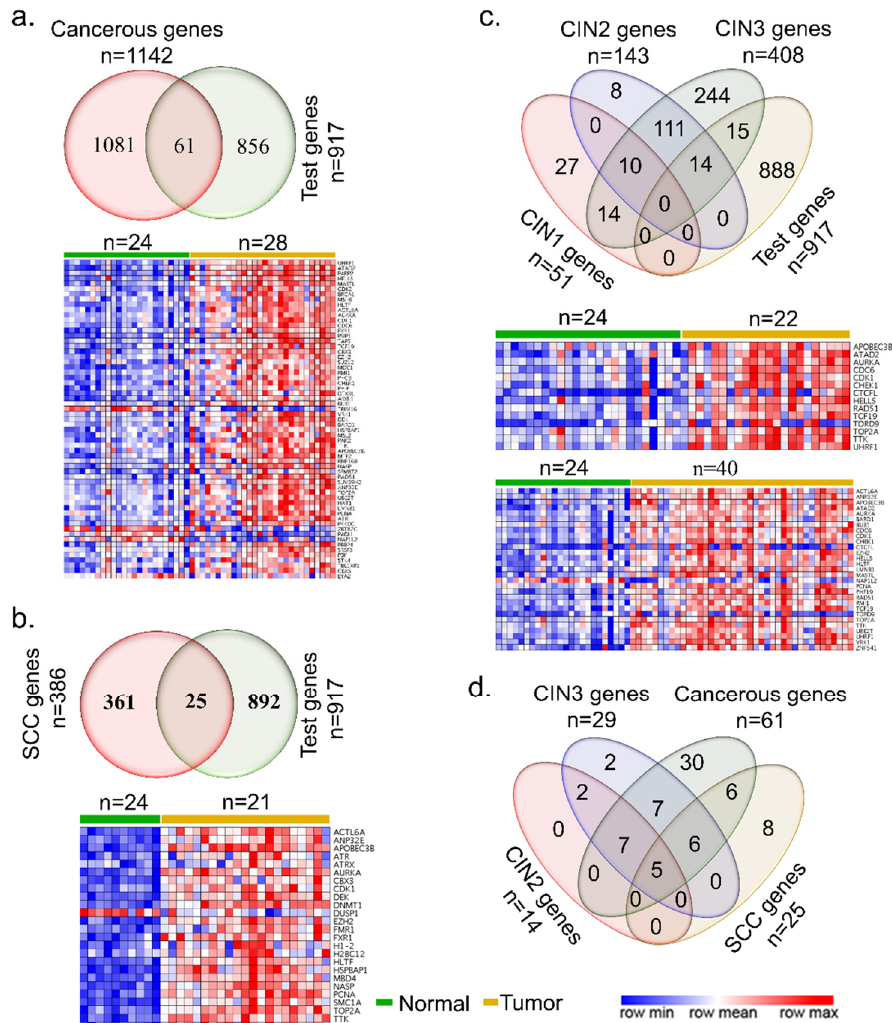
Figure 1. Epigenomic and chromatin regulators in cervical cancer. The Venn diagrams show overlap among the epigenomic and chromatin regulators, and expression heatmaps between the normal and cancerous genes ( a ), squamous cell carcinoma ( b ), CINs ( c ), and overlap under different cancerous conditions ( d ).